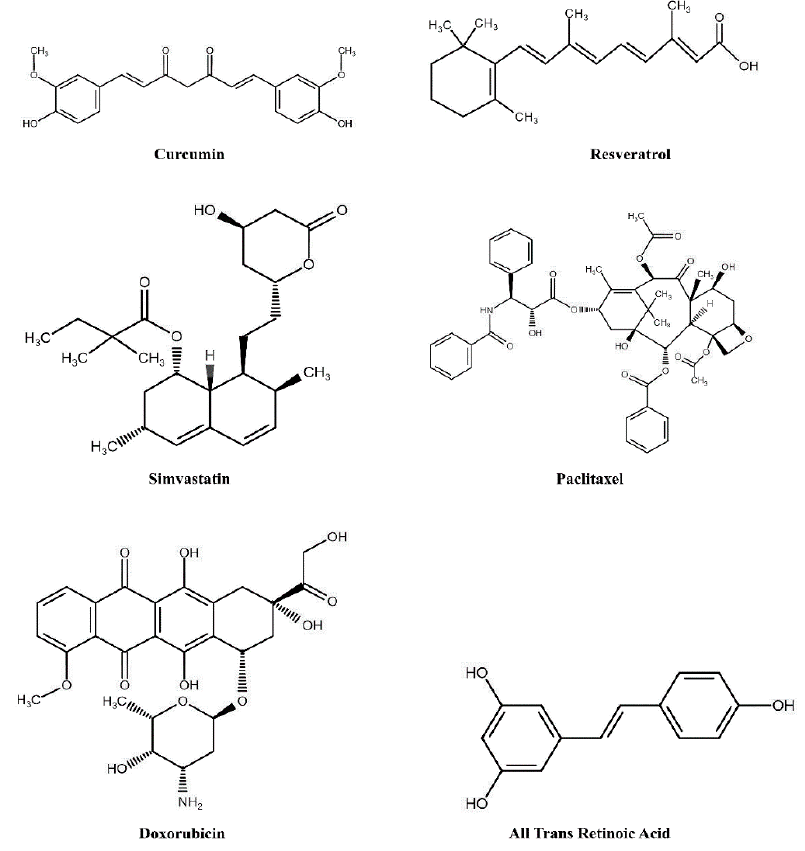
Figure6. Chemicalstructuresofselecthydrophobicagentsthathavebeenincorporatedintolipoproteins. Figure 6. Chemical structures of select hydrophobic agents that have been incorporated into (cid:48) Resveratrol (3,5,4 -trihydroxystilbene) (Figure 6) is another plant derived polyphenol that lipoproteins.